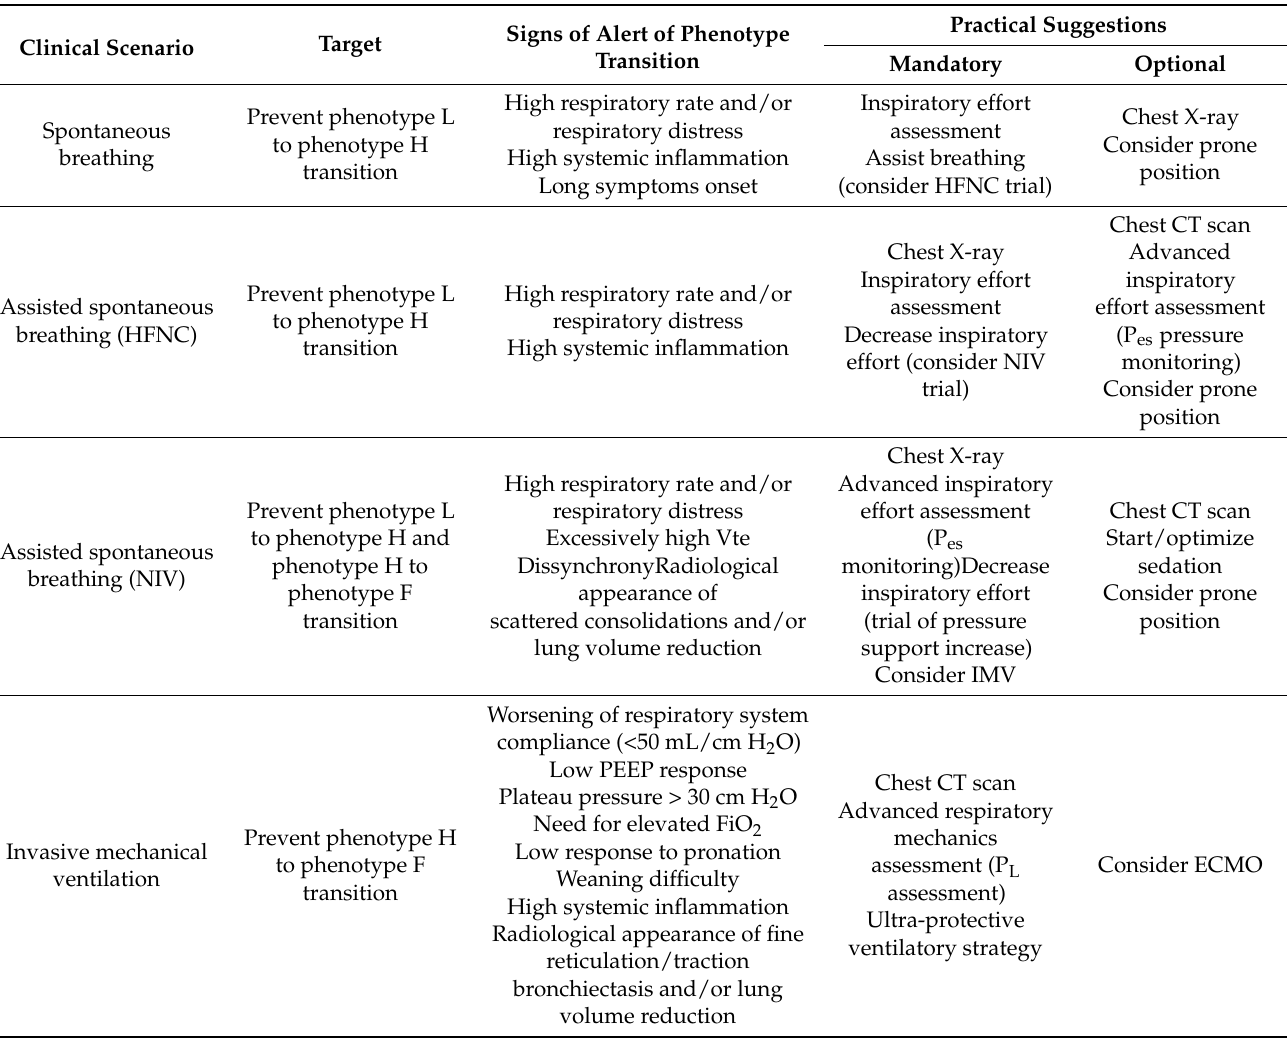
Table 2. Clinical features, mechanical characteristics, and radiological signs of potential phenotype transition across difference clinical scenarios and practical management